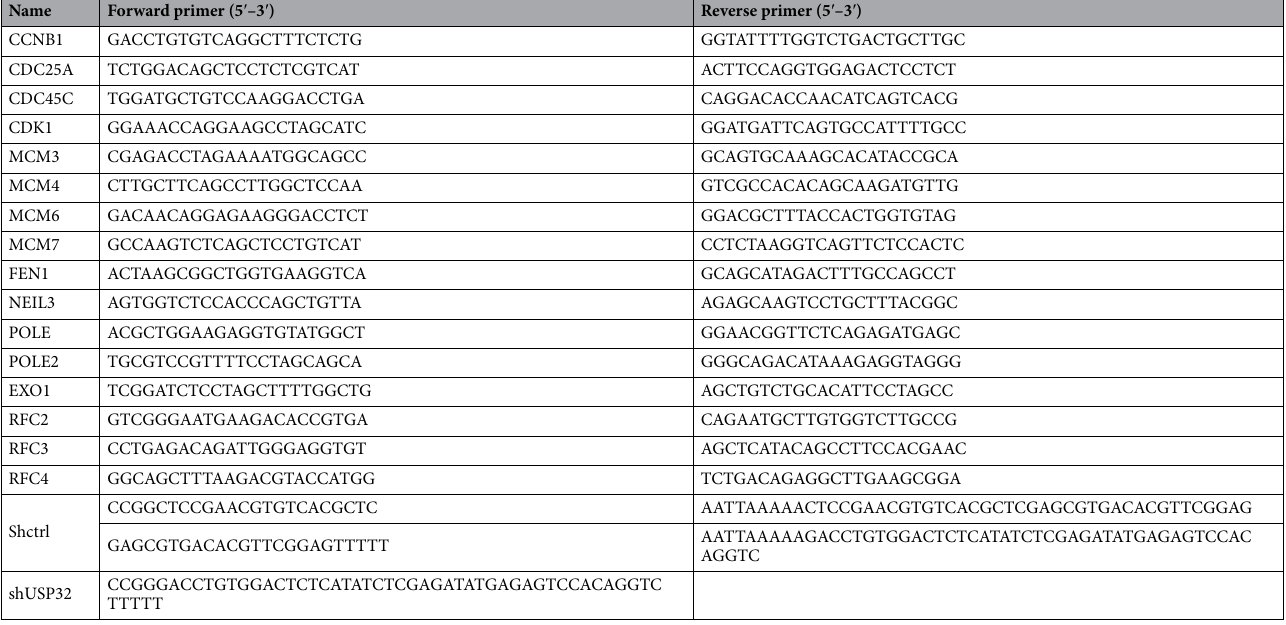
Table 2. Primers for RT-qPCR and plasmid